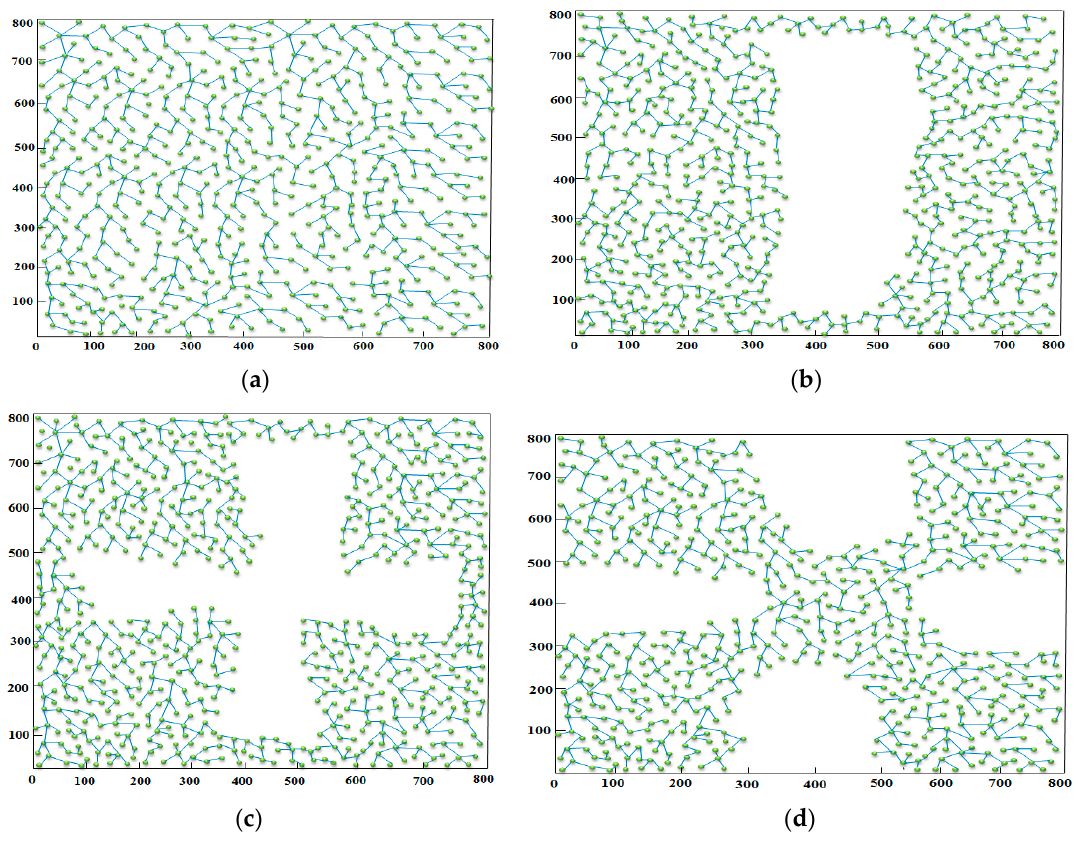
Figure 3. Four scenarios considered in the experiments. ( a ) BD-Scenario; ( b ) UD1-Scenario; ( c ) UD2-Scenario; ( d ) UD3-Scenario.